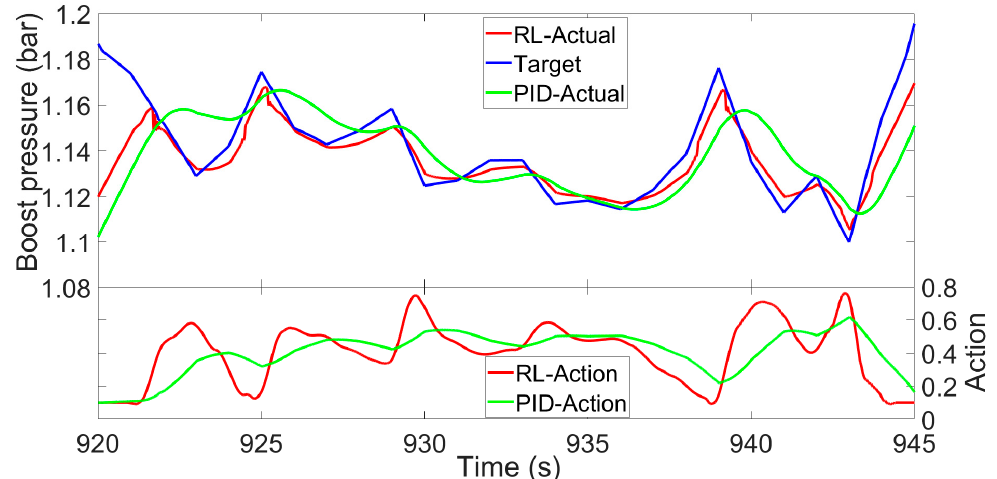
Figure 15. Control performance comparison between the fine-tuned PID and the proposed DDPG from the time period of 920 s to 945 s.